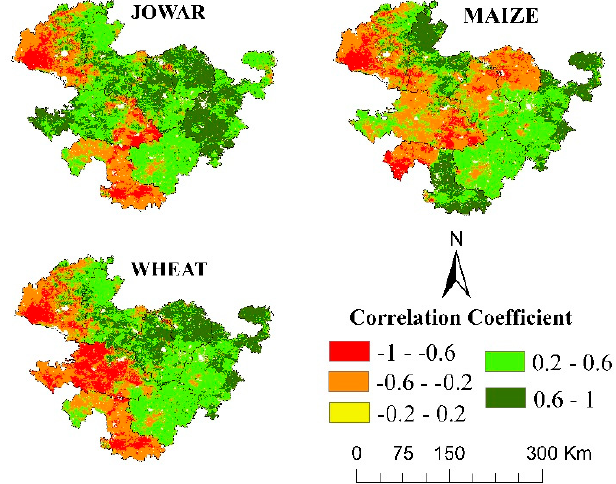
Figure 13. Spatial variations in the correlation of Rabi crop yields in Marathwada and CDI_M values. Table 6. Correlation and regression between CDI_M values and crop yield anomalies for the Rabi season.